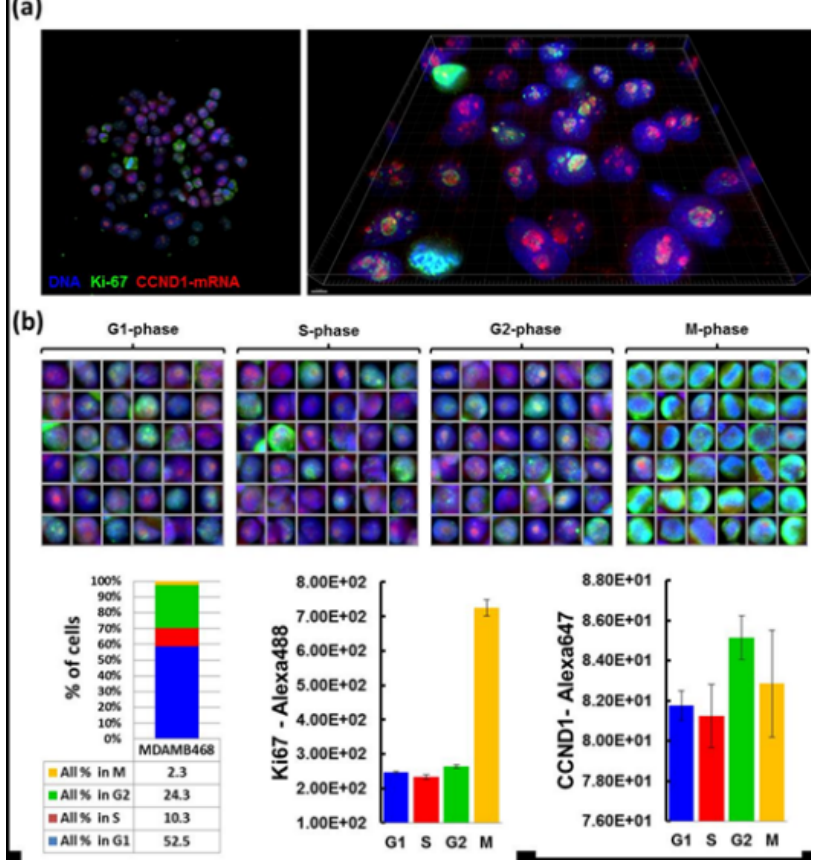
Figure 9. Application of Quantitative RNA ISH on breast cancer cells. ( a ) shows the nuclei of breast cancer cells visualized with two fluorescent dyes—green with gene Ki-67 and red with gene CCND1. The nuclei are seen on the left at 20× magnification, and on the right at high resolution. ( b ) shows numerous pictures of nuclei with monitored genes in each phase of the cell cycle. The panel in the table at the bottom of the picture contains quantitative analysis of gene expression, showing that the majority of expressions in gene Ki-67 are observed in mitotic phase, while in gene CCND1 there are the highest number of expressions in the G2 phase of the cell cycle [67].